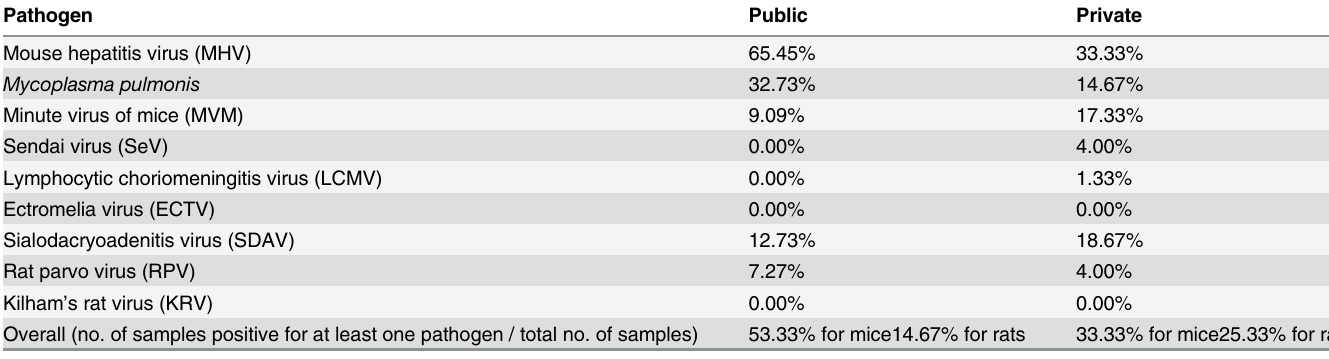
Table 4. Incidence of various pathogens in public (55 samples) and private (75 samples) vivaria.